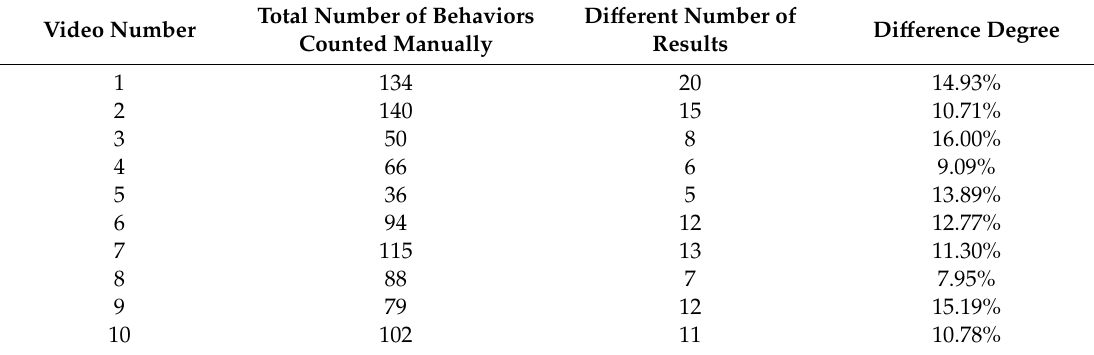
Table 4. Statistical di ff erences.